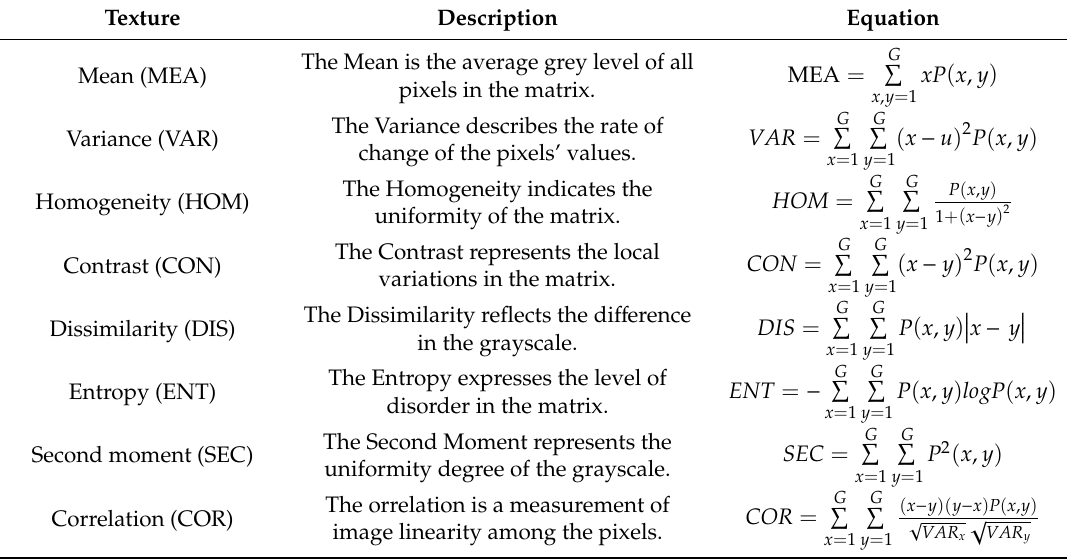
Table 3. The grey-level co-occurrence matrix (GLCM) textural features used in this